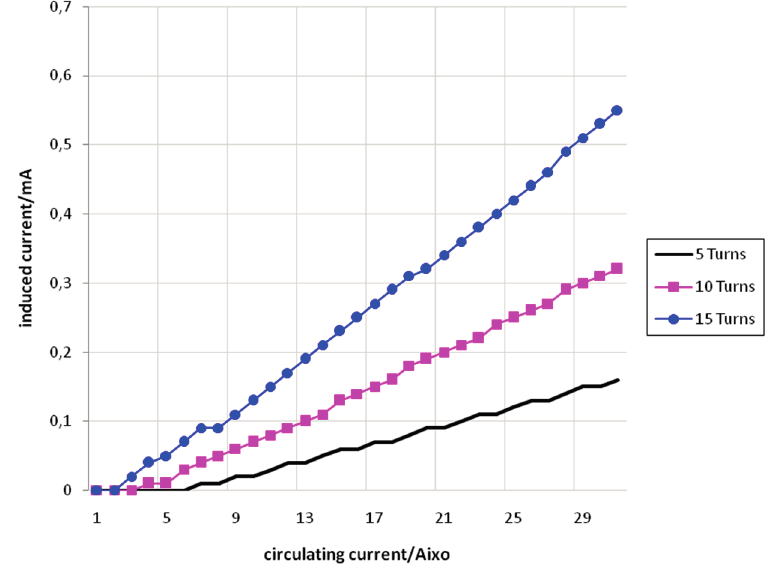
Figure 10. I f versus I i for the conductor of 6mm 2 with 5 turns (black), 10 turns (pink), and 15 turns